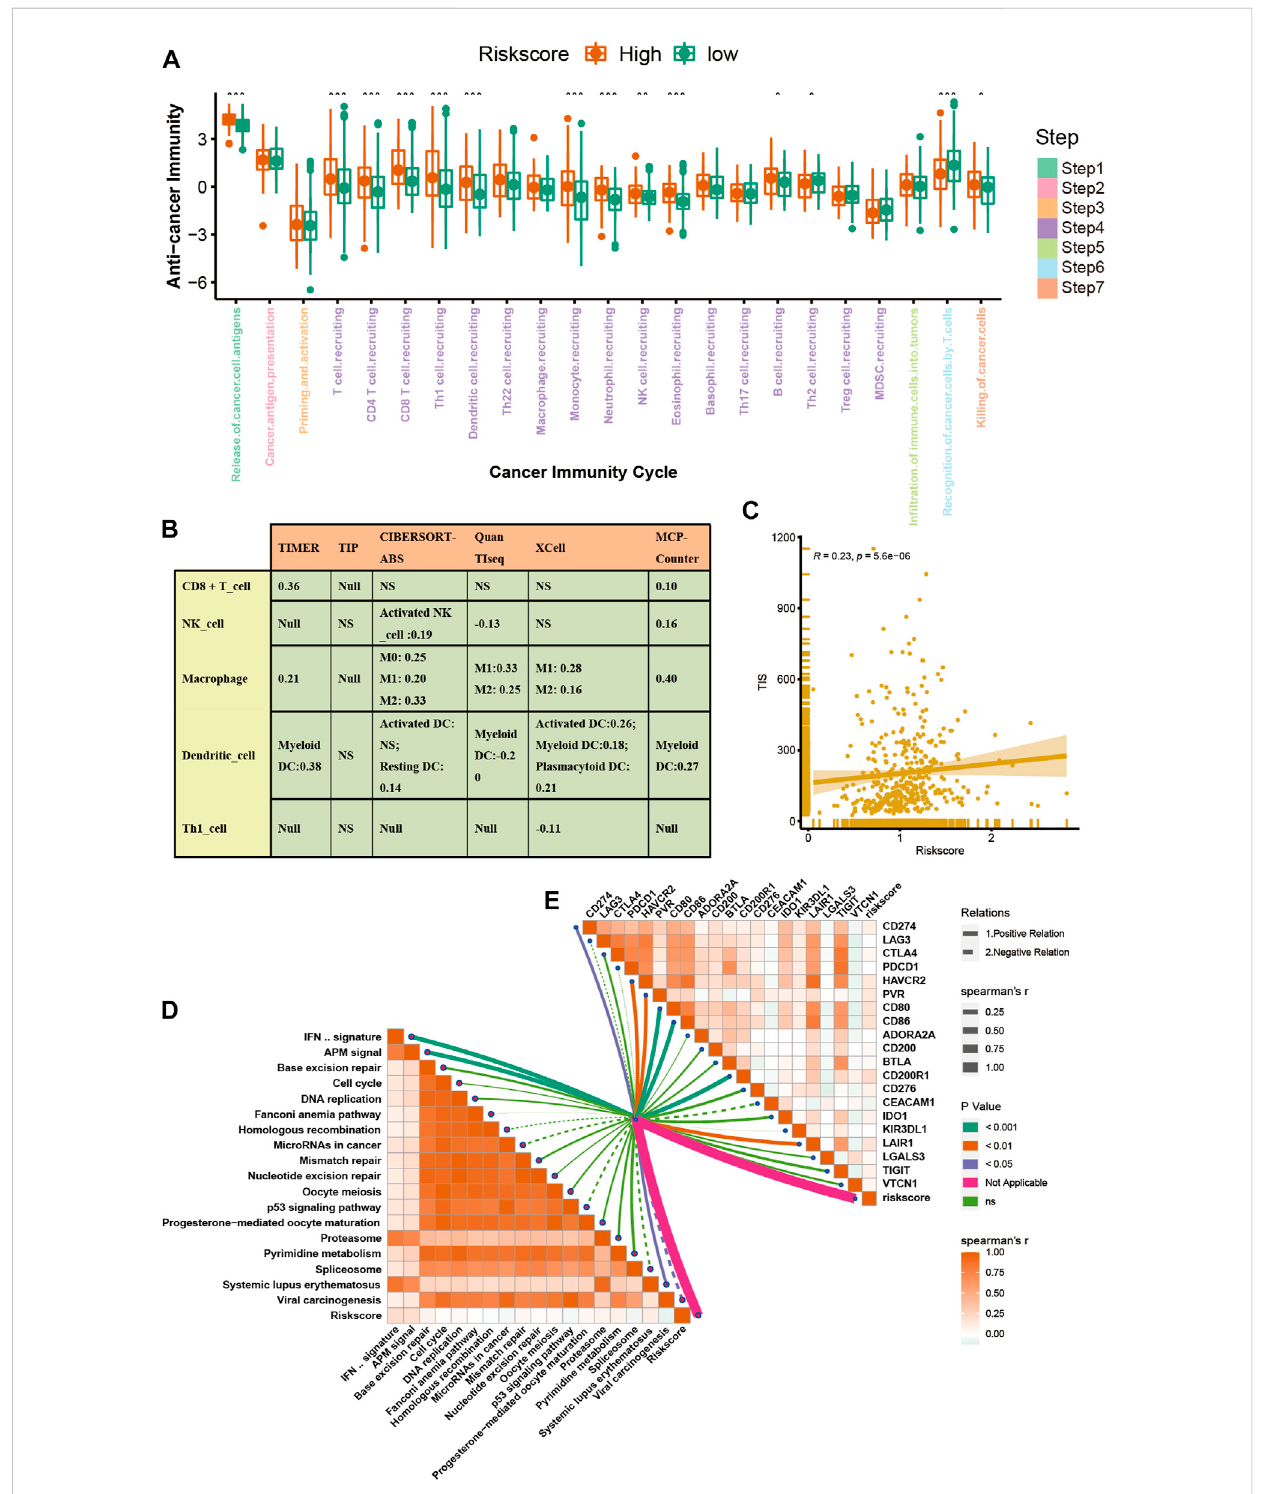
FIGURE 5 VM_Score correlated with the tumor immune microenvironment characteristics. (A) Differences in cancer immune cycling activity between high- andlow-risk groups. (B) RelationshipbetweenVM_Scoreandseveral immune cells(CD8 + Tcells, NKcells,macrophages, Th1 cells,andDCs) in six independent algorithms. (C) Relationship between VM_Score and T cell in fl amed score (TIS). (D) Correlation between VM_Score and enrichment of ICB response – related pathways. (E) Relationship between VM_Score and immune checkpoints (* p < 0.05; ** p < 0.01; *** p <